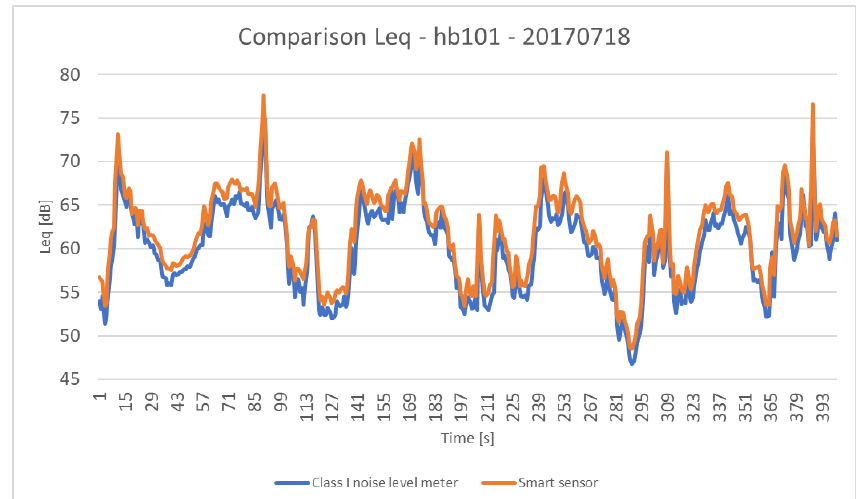
Figure 4: Broad band check (by using road traflc noise), considering 7 minutes as measurement time period – Time history of sound pressure levels, in terms of LAeq,1s [dB(A)]